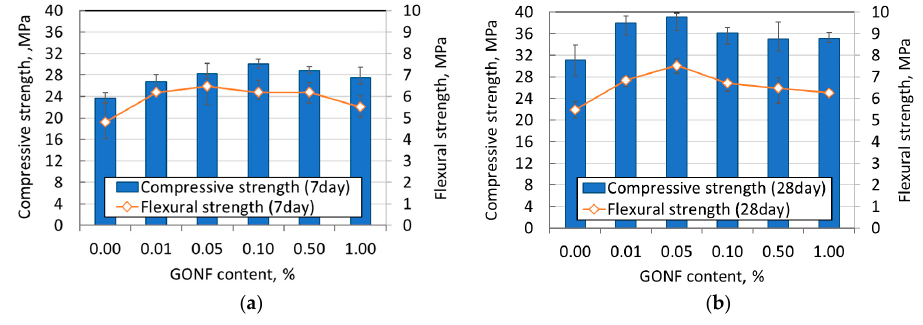
Figure 8. Compressive and flexural strength results of GONF-combined paste with Wet-mix design method. ( a ) Mechanical properties of PW (7 days); ( b ) Mechanical properties of PW (28 days).